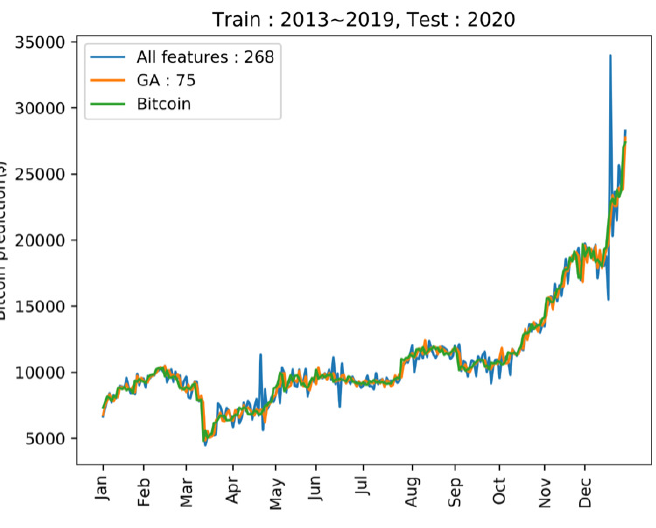
Figure 9. Prediction of Bitcoin in 2020. Table 5. Prediction of the direction of Bitcoin price. Results without feature selection (left) and with the genetic wrapper